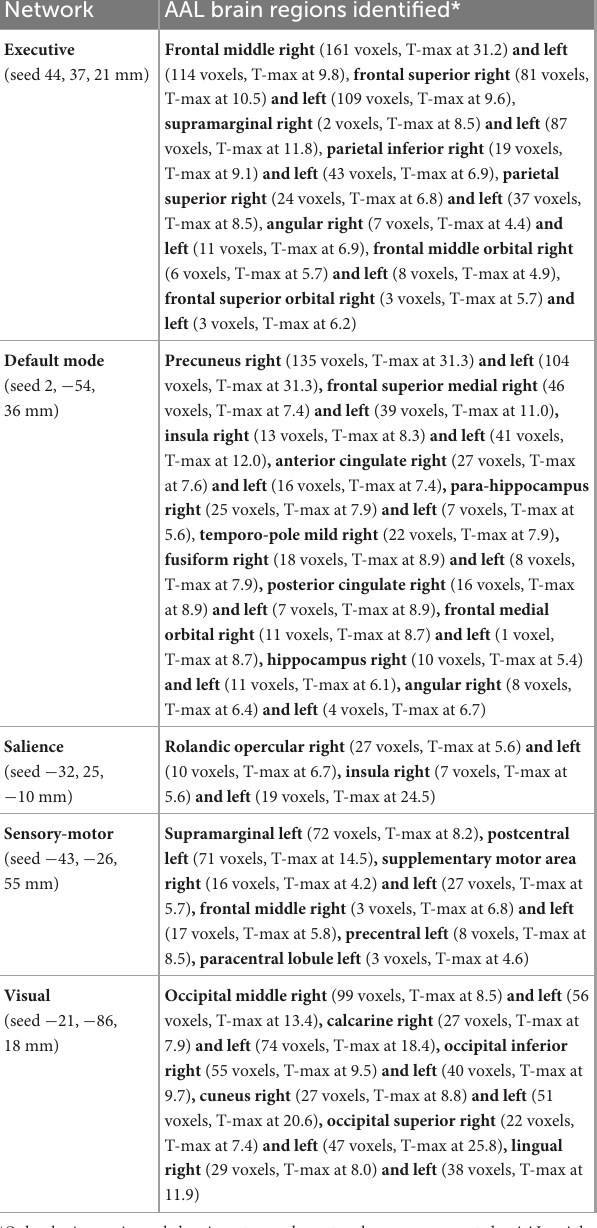
TABLE 1 Brain regions usually belonging to each network and identified by seed correlation analyses (p-voxel < 0.001, uncorrected, corrected for the cluster